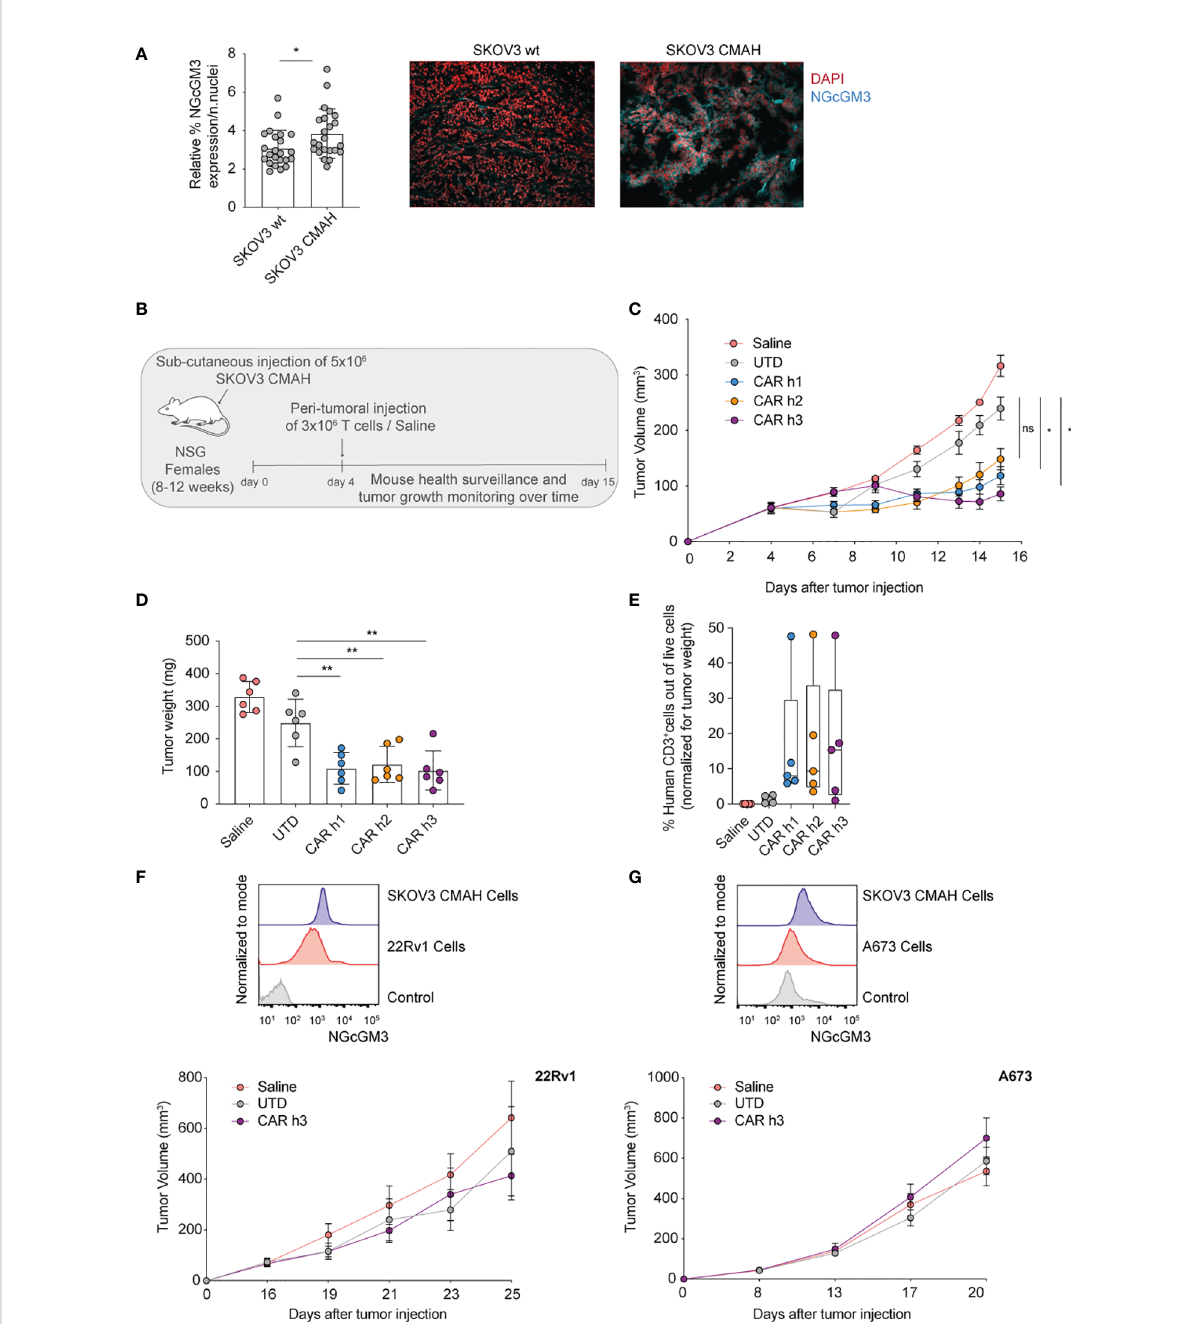
FIGURE 2 Anti-NGcGM3 CARs T cells ef fi ciently control the in vivo tumor growth of an ovarian human tumor cell line expressing the target antigen. (A) Relative expression of NGcGM3 on SKOV3 wt versus SKOV3 CMAH subcutaneous tumor fragments (left). Representative immuno fl uorescence images (right); DAPI staining of nuclei in red, 14F7 mAb plus Alexa fl uor 647 labeled secondary Ab in blue. (B) Schematic of in vivo ACT study. (C) Tumor growth (SKOV CMAH) curves over days following subcutaneous injection. (D) Tumor weights (SKOV3 CMAH) at the end of the study (day 15). (E) Percentage of human CD3 + T cells in fi ltrating tumors at the end of the study (normalized for tumor volume). (F, G) Relative expression levels of NGcGM3 on SKOV3 CMAH, 22Rv1 and A673 tumor cells assessed by fl ow cytometry (control = secondary Ab alone) (top). Tumor growth curves for 22Rv1 and A673 over days (in this ACT study the mice received 2x10 6 CAR T or UTD cells by peritumoral injection at days 16 and 8, respectively, post tumor injection) (bottom). Shown is average ± SD (A, D) or ± sem (C) and ( F , G , bottom panels) or box and whiskers (min to max) (E) . Statistical analysis by unpaired, two-tailed Mann-Whitney test (A) and paired, two-tailed t test (D) ; two-way analysis of variance (ANOVA) with correction for multiple comparisons by post hoc Tukey ’ s test (C) ; unpaired, two-tailed t test (D) .(**p< 0.01; *p < 0.05; ns, non-signi fi